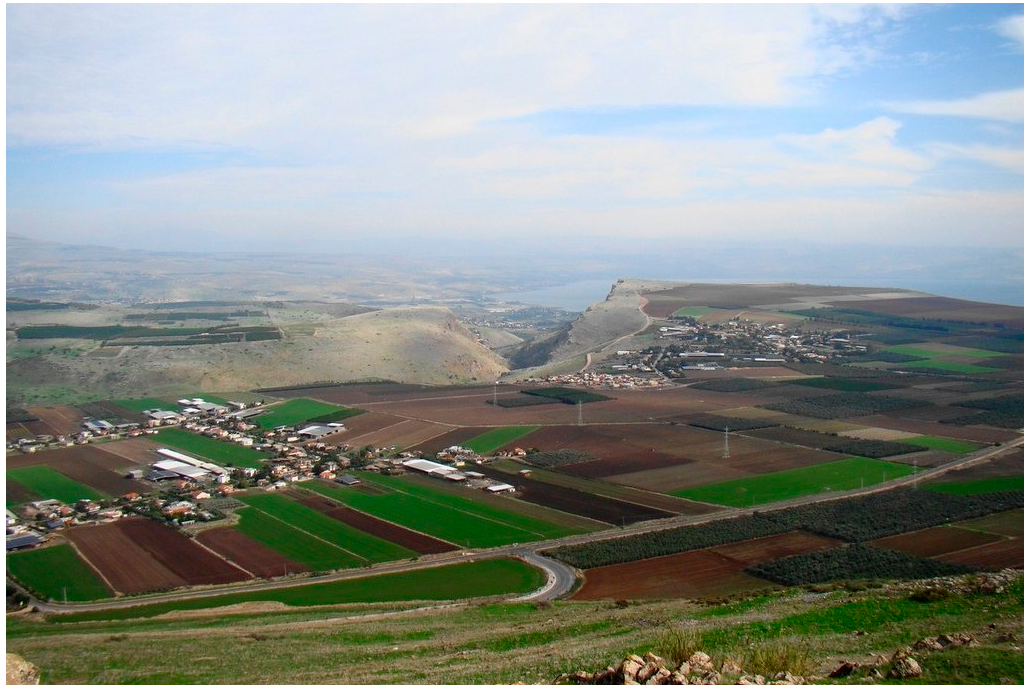
Figure 4. Scenery seen from the small valley between the two Horns of Hattin: the plateau, the (modern) villages and, beyond the Arbela Gorges, the Lake of Genezareth as Maria Valtorta narrates. Photograph downloaded 10 January 2020: https://www.awesomestories.com/images/user/e785cca68a323a2c5dc63cd8713a614b.jpg.